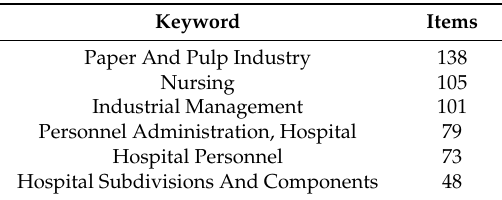
Table 2. Keywords related to professions.